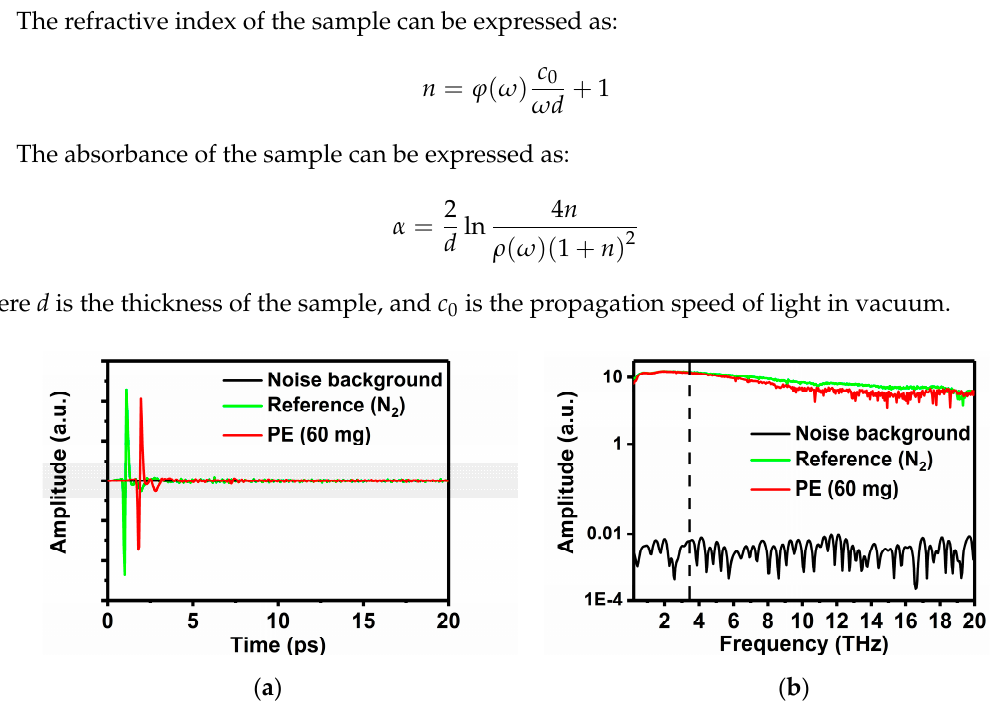
Figure 2. Waveforms of the noise background, reference and PE of ABCD system. ( a ) Time domain spectrum; ( b ) Fourier transmitted spectrum.